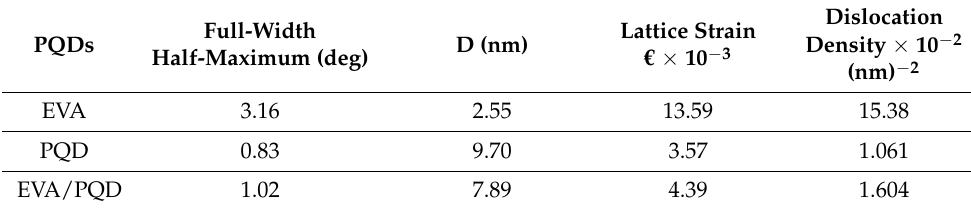
Table 1. Structure of the EVA-modified PQD and the pure PQD thin films in the (110)